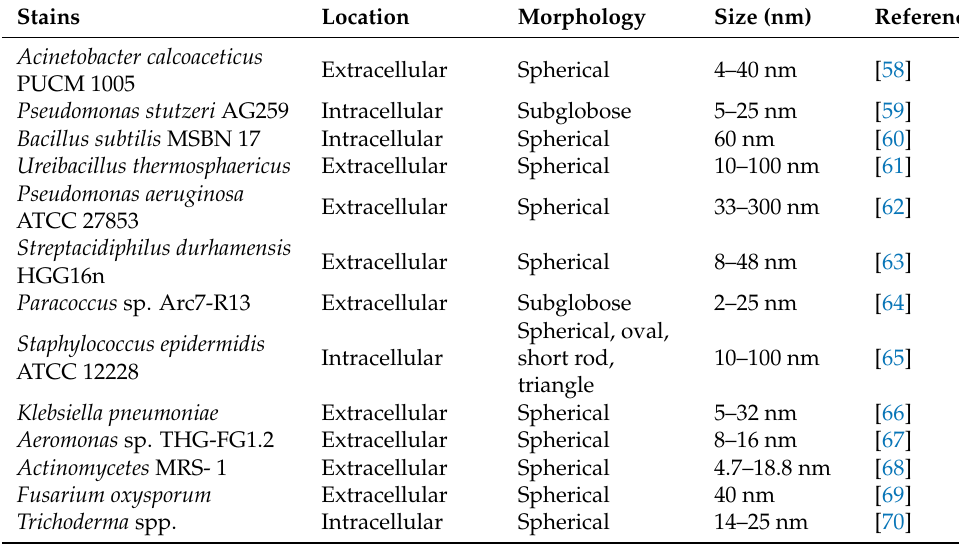
Figure 4. TEM image ( A ) and size distribution ( B ) of Ag@AgCl NPs. Table 2. The summary of AgNP synthesis from the bacteria .